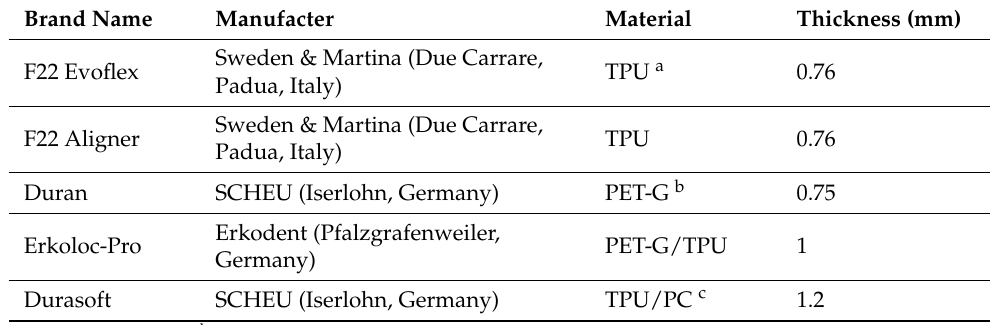
Table 1. Materials tested in the